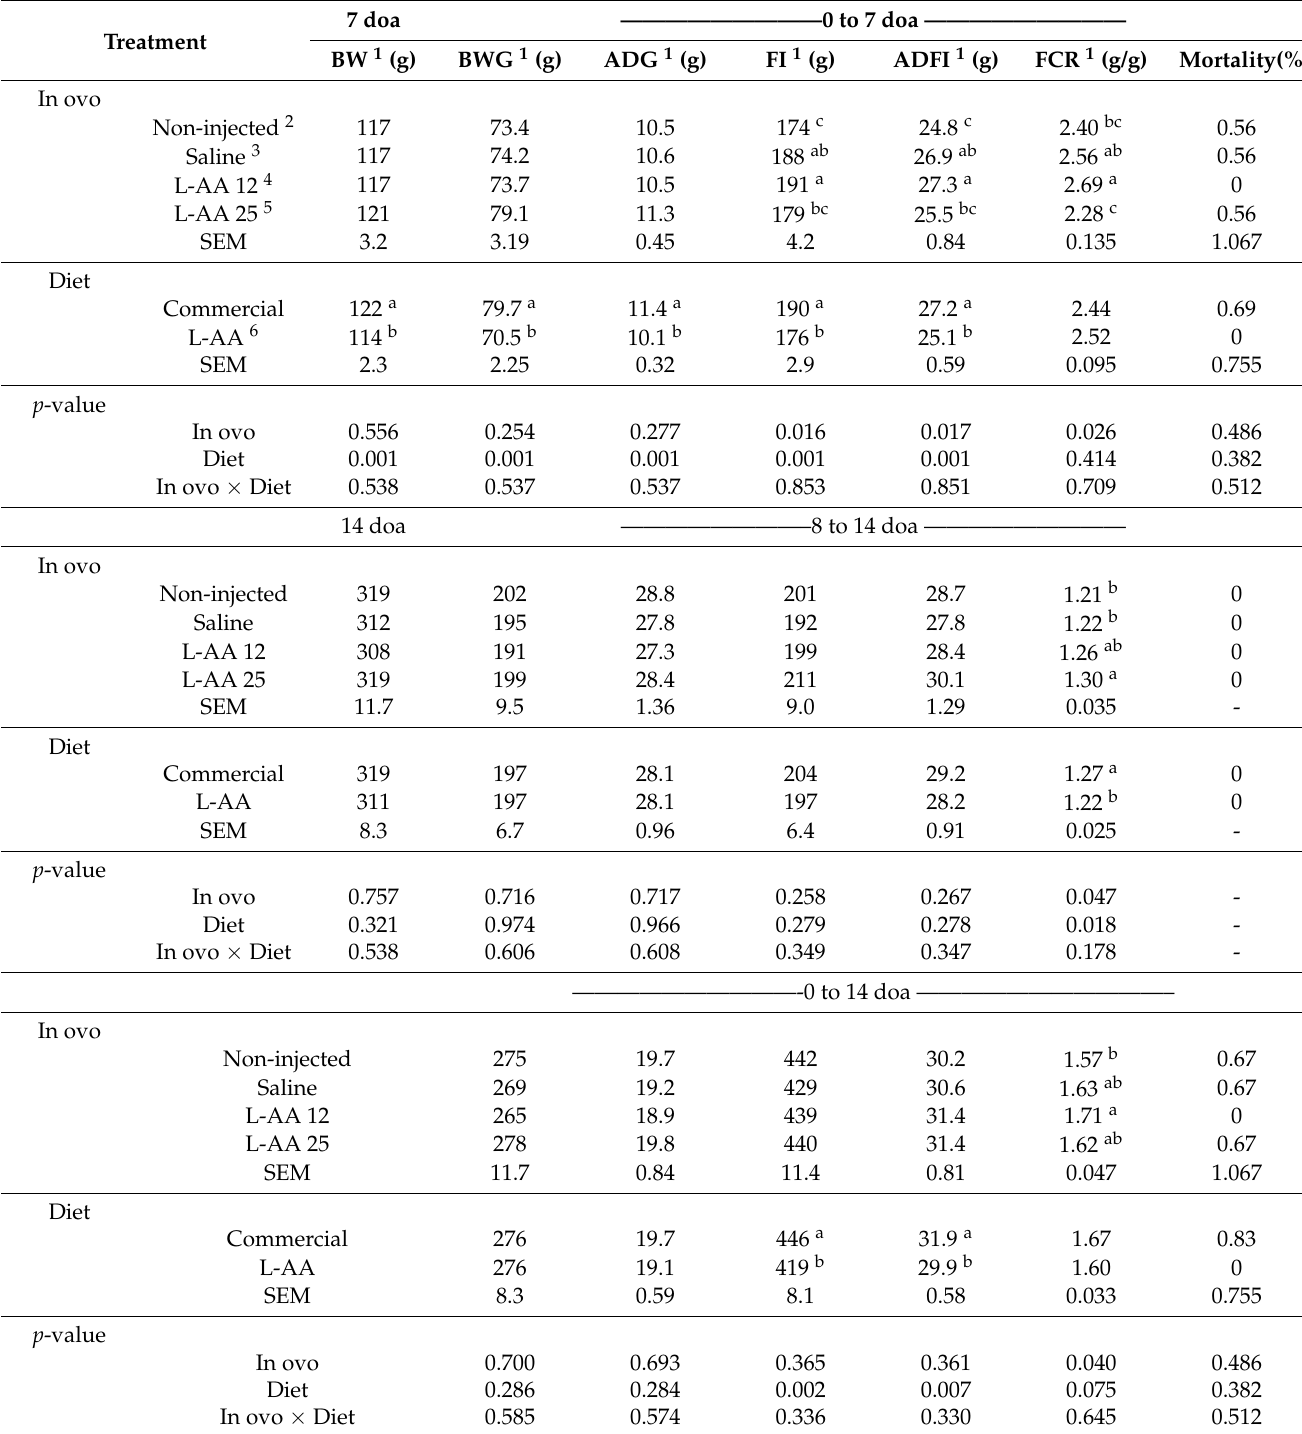
Table 4. Effects of treatment non-injected; saline-injected (saline); saline containing 12 mg of L- a commercial diet or a diet supplemented with 200 mg/kg of L-AA on live performance